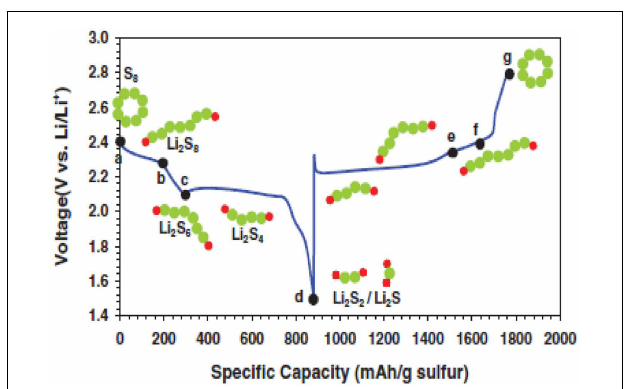
articles appear on the fundamental chemistry (Akridge et al., FIGURE 2 | First discharge and charge profiles of a Li–S cell between 1.5 and 2.8V vs. Li + /Li [adopted from Barghamadi et al. (2013)] .